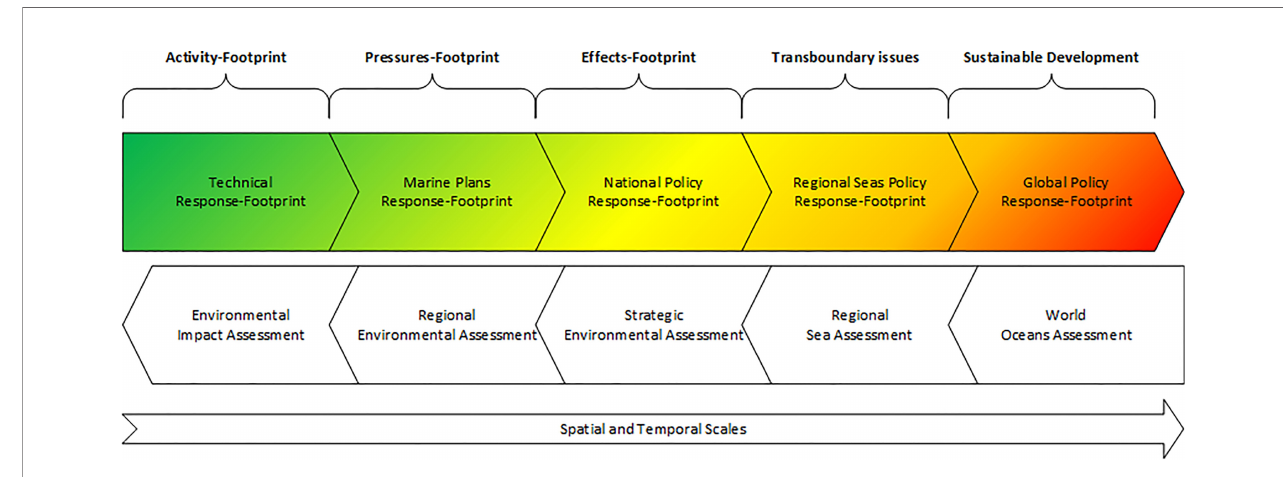
FIGURE 3 | Vertical integration